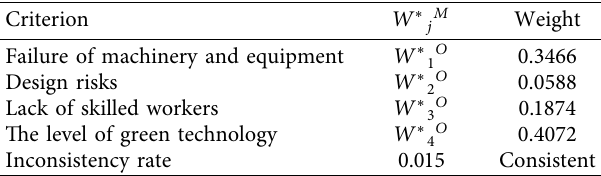
Table 7: Average weights of operational risk criteria.